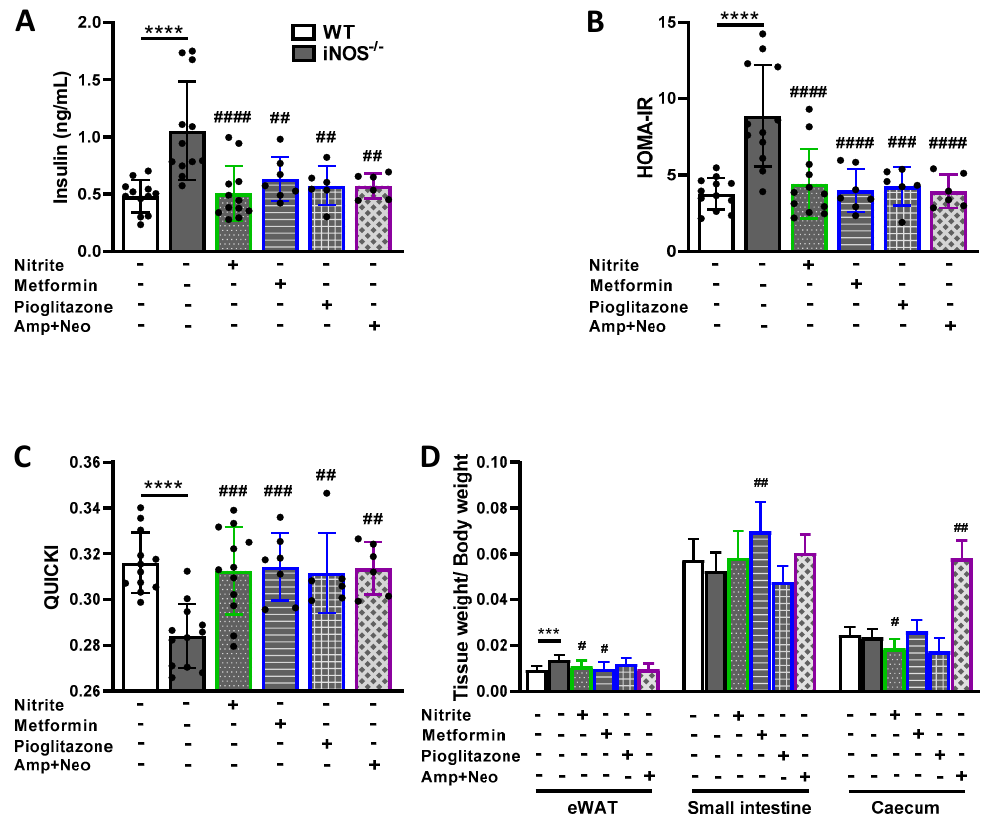
Figure 4. Modulation of insulin homeostasis in iNOS -/- mice by nitrite, metformin, pioglitazone, and a combination of ampicillin-neomycin. ( A ) Fasting serum insulin levels; Indices of insulin resistance ( B ) HOMA-IR and insulin sensitivity ( C ) QUCIKI ( n = 6–12). ( D ) Relative tissue weights ( n = 4–12). Data are represented as mean ± SD. *** p < 0.001 and **** p < 0.0001 vs. WT; # p < 0.05, ## p < 0.01, ### p < 0.001 and #### p < 0.0001 vs. iNOS -/- .